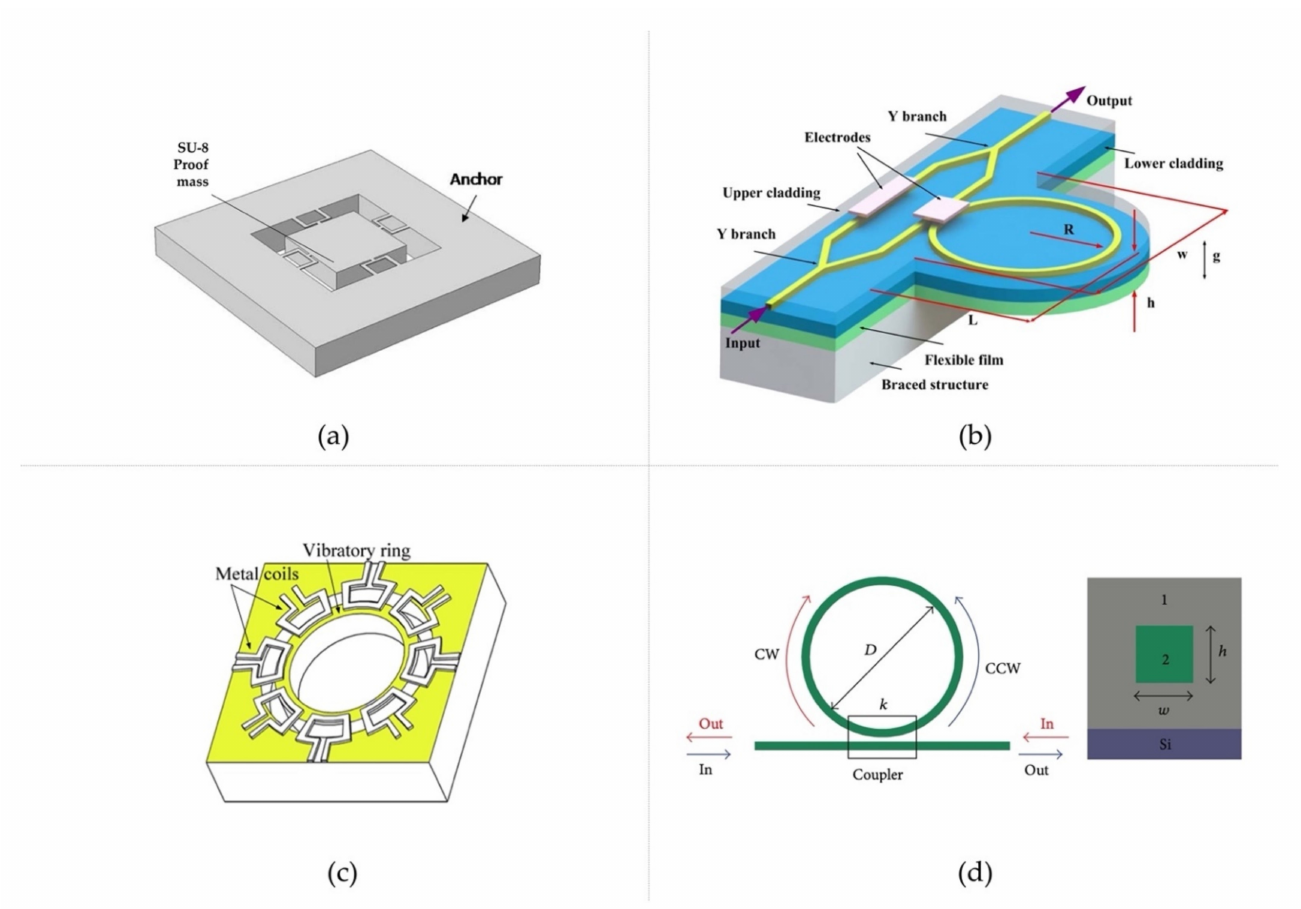
Figure 2. ( a ) SU-8 3-axis piezoresistive accelerometer, reprinted with permission from [20]. Copy- right IEEE 2019. ( b ) Polymeric Fano-resonator-based accelerometer, reprinted with permission from [21].Copyright The Optical Society2016. ( c ) Polymeric vibratory ring-type MEMS gyroscope, reprinted with permission from [27]. Copyright IEEE 2008. ( d ) Polymeric ring resonator for optical gyroscope, reprinted from [26], Hindawi,